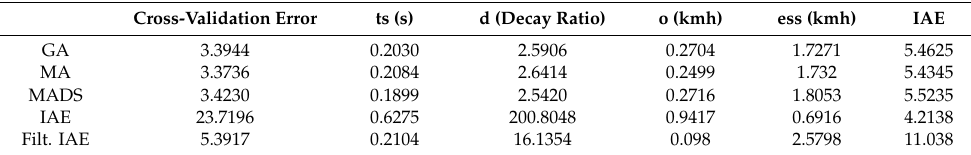
Table 2. Signal disturbance test results.